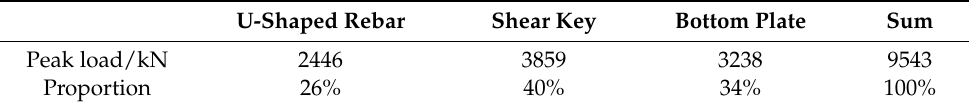
Table 4. Contribution rate of different structures.